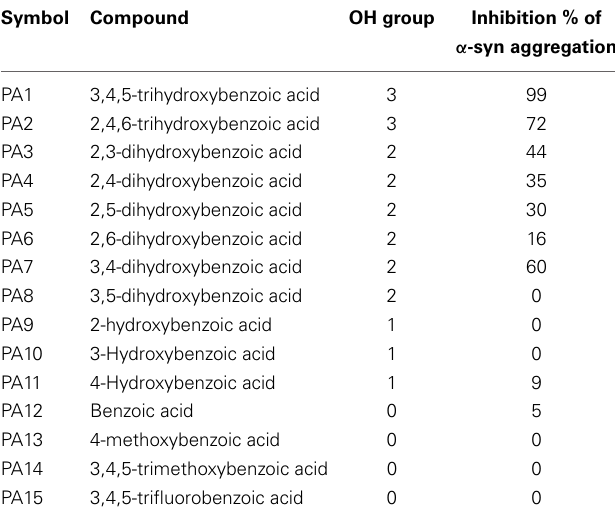
Table 3 | Summary of Th-S results showing the percentage of inhibition of fibril formation comparing with number of OH groups around the phenyl